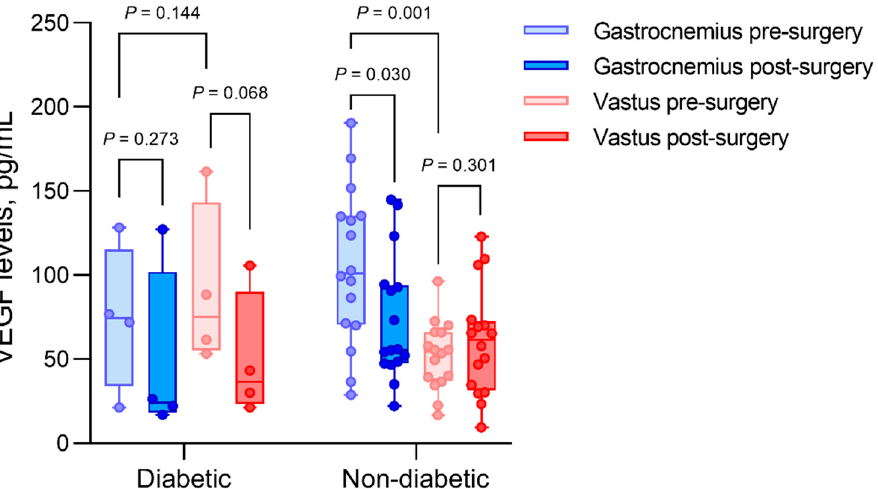
Figure 3. Intramuscular VEGF concentrations of patients with diabetes compared to nondiabetic patients in gastrocnemius and vastus lateralis muscle biopsies, before (pre) and after (post) revas- cularization. Gastrocnemius muscles are considered ischemic, and vastus muscles are considered as non-ischemic controls. VEGF levels were not different when comparing hypertensive to non- hypertensive patients, as for dyslipidemia, sex, smoking status, and chronic kidney disease. VEGF levels were not correlated to BMI, age, or ABI.